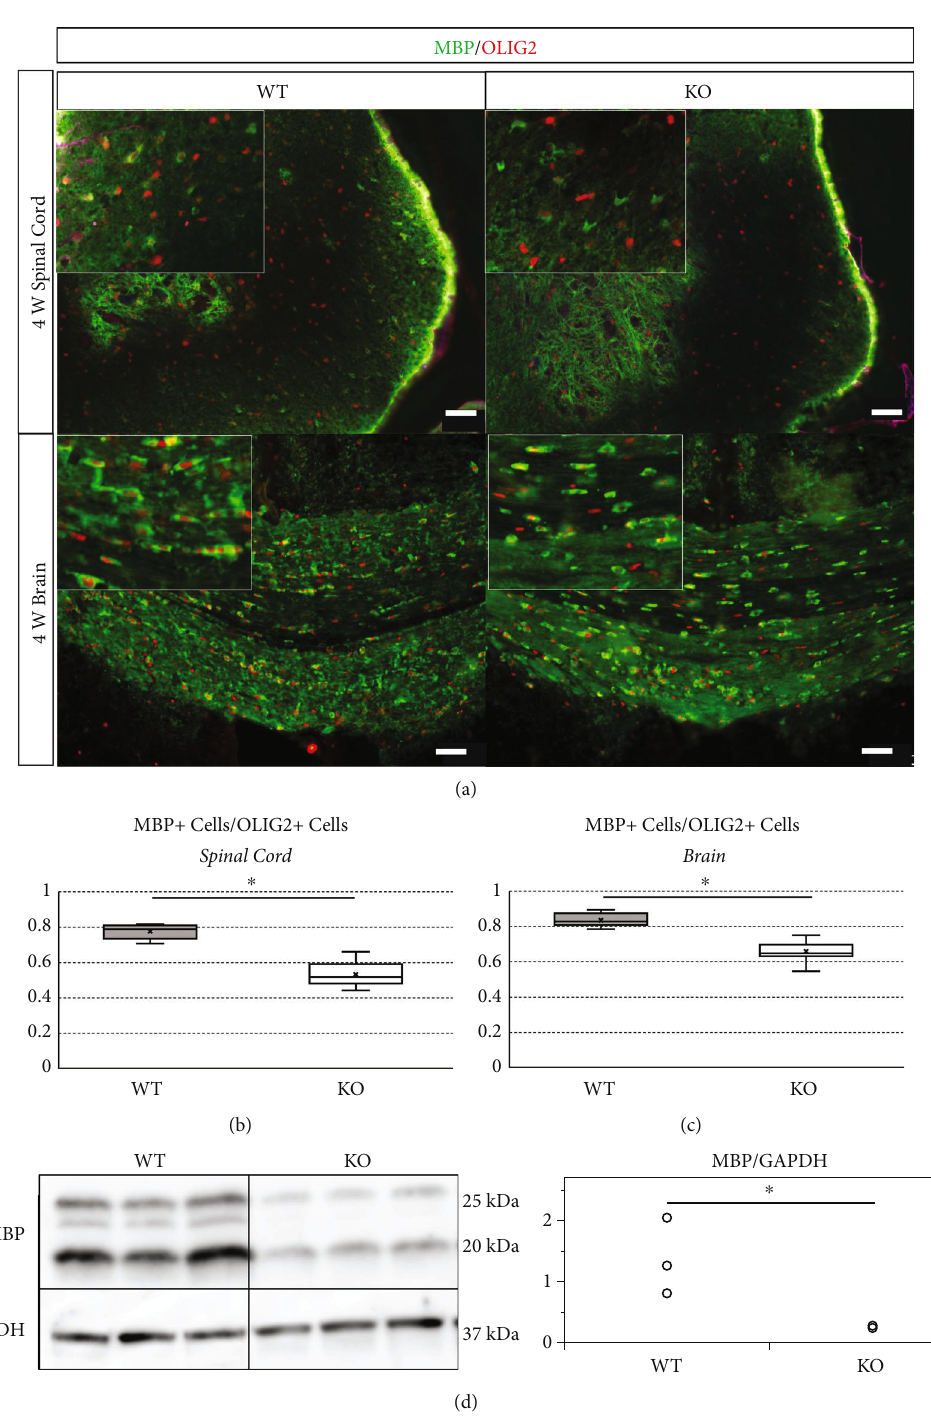
Figure 9: Myelinating oligodendrocytes of the spinal cord and brain at 4 weeks of age. Wild-type (WT) and miR-23-27-24 cluster knockout (KO). (a) Sections of the spinal cord and brain were immunostained for myelin basic protein (MBP) and OLIG2. Cells that were double positive for MBP and OLIG2 were considered myelinating oligodendrocytes. Scale bars: 50 μ m. (b) In the spinal cord, the ratio of the number of myelinating oligodendrocytes to the number of OLIG2-positive mature oligodendrocytes was signi fi cantly lower in KO mice than that in WT mice, n = 6 per genotype, ∗ p < 0 : 05 . (c) In the brain, the ratio of the number of myelinating oligodendrocytes to the number of OLIG2-positive mature oligodendrocytes was signi fi cantly lower in KO mice than that in WT mice, n = 6 per genotype, ∗ p < 0 : 05 . (d) Representative western blots of MBP and GAPDH proteins in the spinal cord of 4-week-old mice. MBP expression was signi fi cantly lower in KO mice than that in WT mice, n = 3 per genotype, ∗ p < 0 : 05